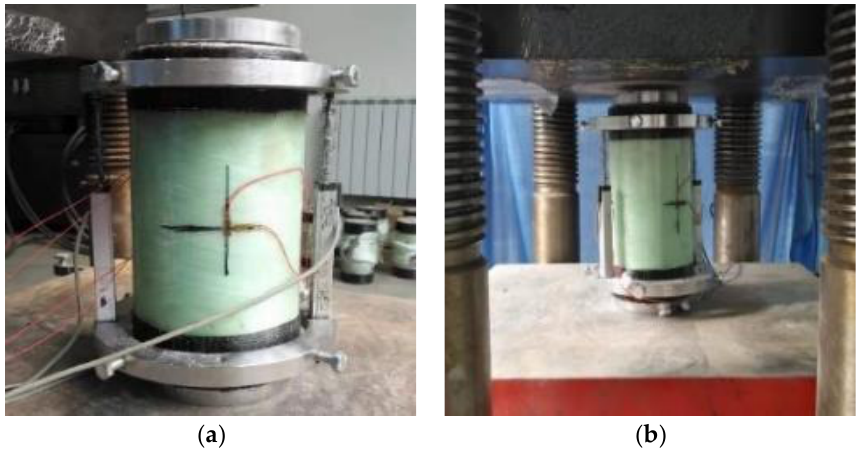
Figure 3. Loading device and specimen arrangement. ( a ) Specimen arrangement. ( b ) Loading device.